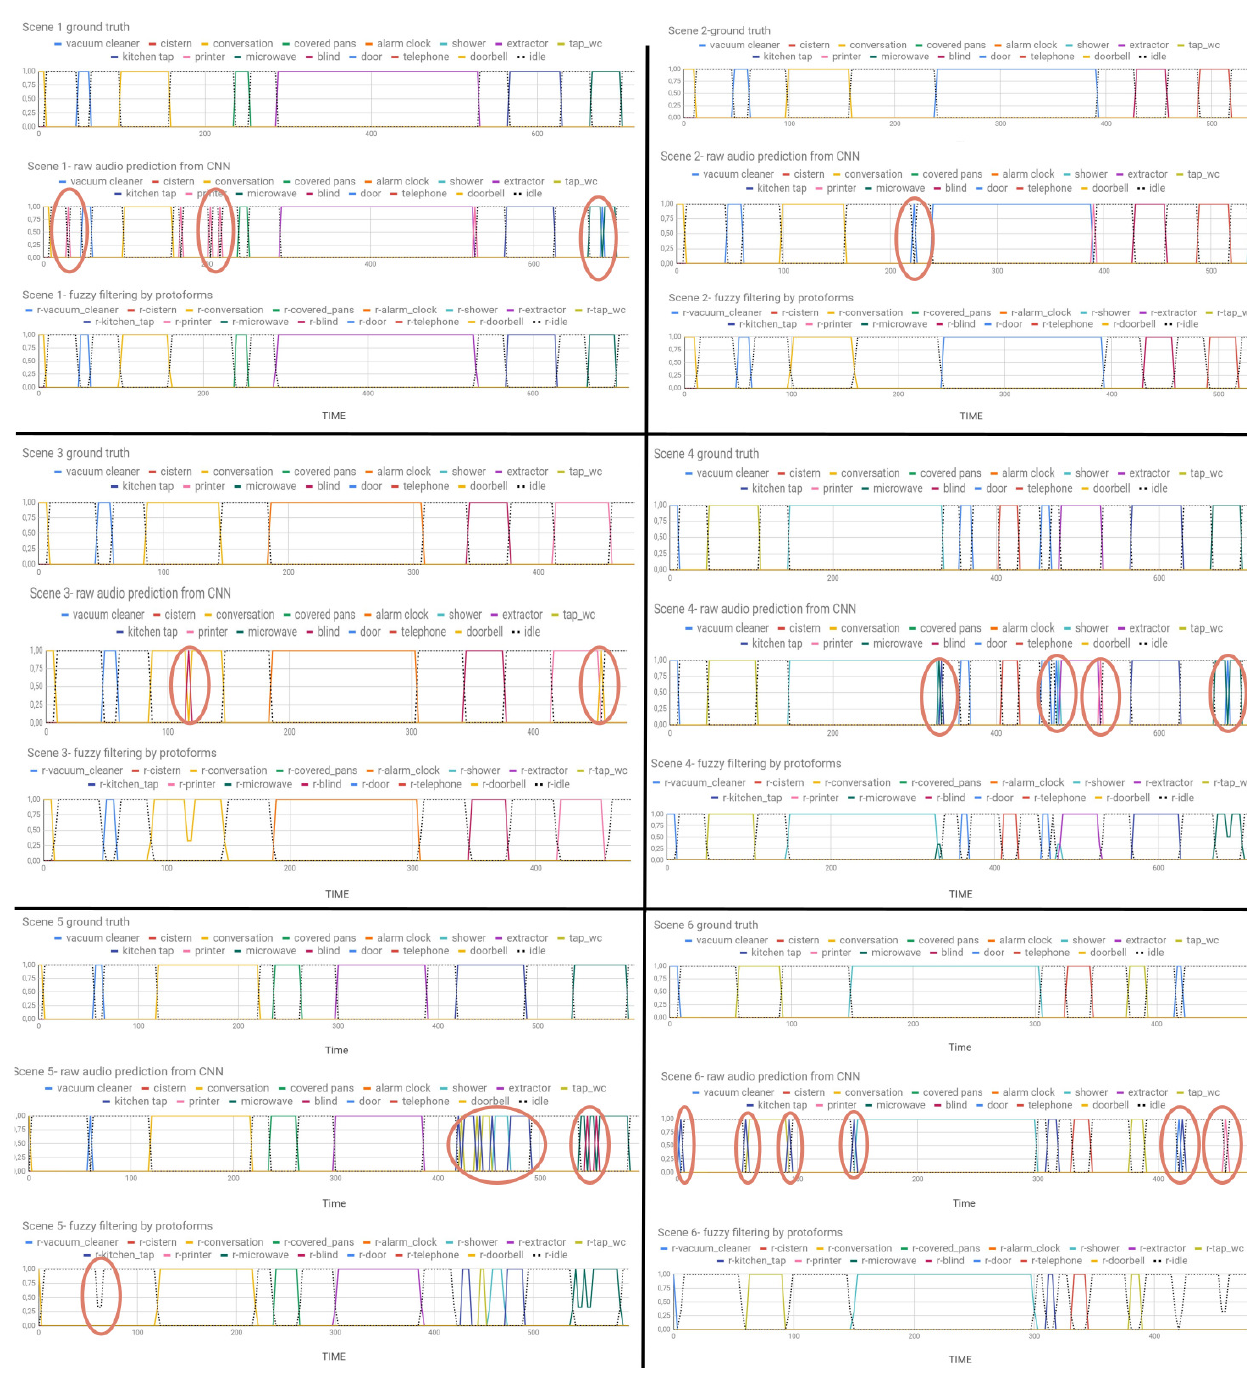
Figure 6. Timeline of the six scenes of the case study: ( Up ) ground truth of the scene; ( Middle ) raw audio recognition from spectral and CNN models; ( Bottom ) fuzzy filtering of audio recognition with protoforms. In red circles are the isolated false positives or false negatives which describe incoherent event